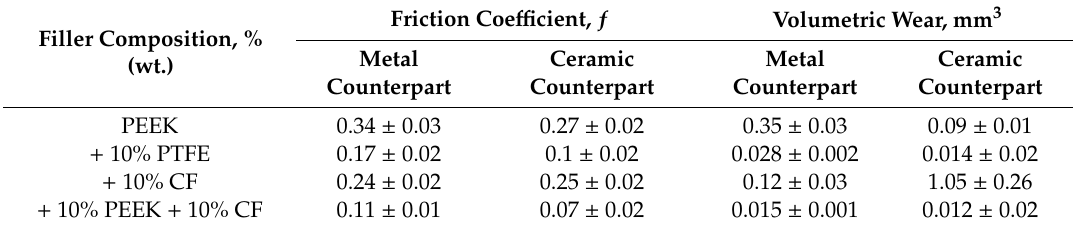
Table 3. Tribological properties of the PEEK-based composites.